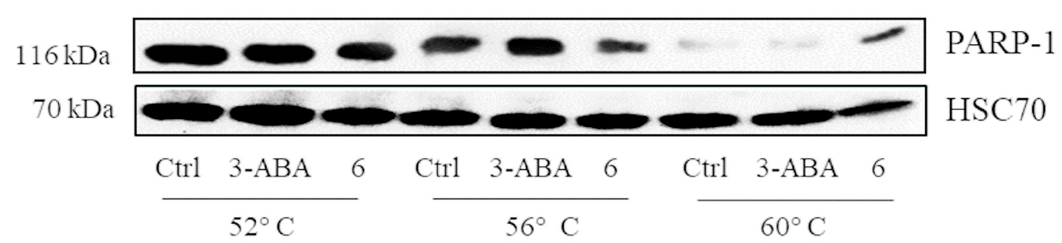
Figure 6. Cellular thermal shift assay (CETSA ® ) for in-cell PARP-1 target engagement. Representative Western blot showing thermostable PARP-1 following indicated heat shocks (range of 52–60 °C) in MSTO-211H cells, untreated (Ctrl) or treated with 6 or 3-ABA (50 µM) for 15 min. HSC70 was used as loading control.